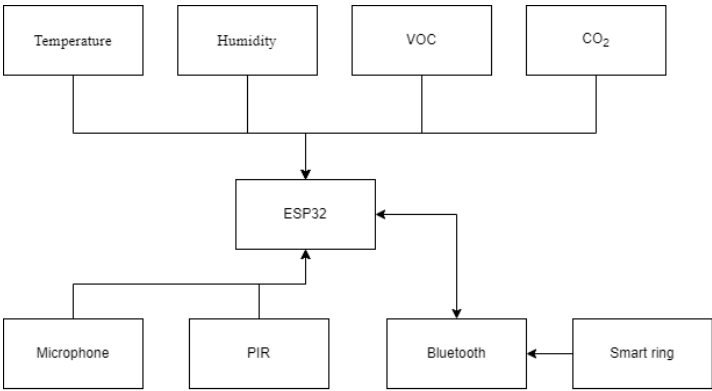
Figure 1. Connection of components.